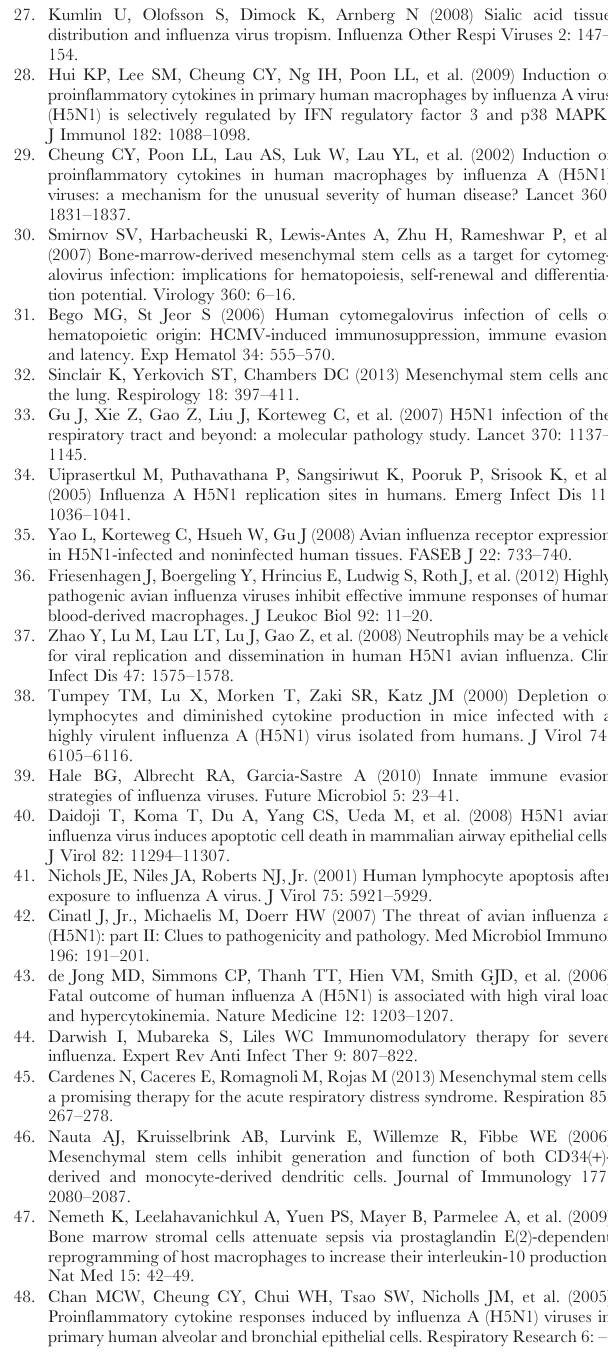
Figure S5 H5N1 did not induce IL-1 b , IL-8, and GM-CSF in cocultures. (A) IL-1 b , (B) IL-8, and (C) GM-CSF levels were measured using a Bio-plex Cytokine assay. The two different cell types in this experiment were derived from different donors. Data shown are mean 6 SD of two independent experiments. Single asterisk indicates statistically significant differences between mock and infected cells with P values of , 0.05 and double asterisks indicate statistically significant differences between cocultures and monocul- ture groups with P values of , 0.05. n.s. means no significance.